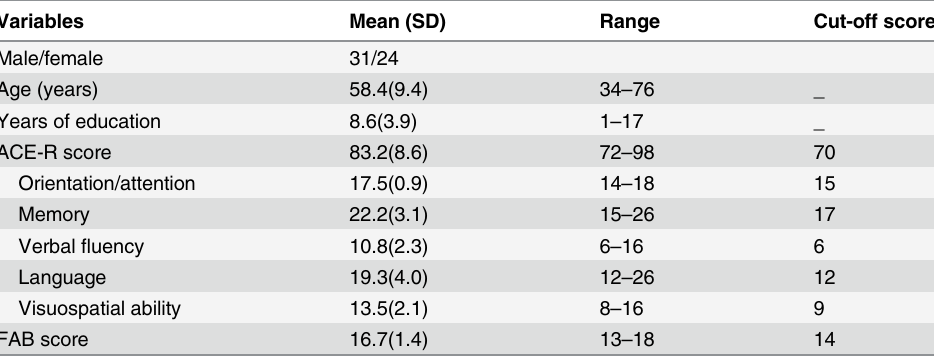
Table 1. Normative data of healthy controls on the ACE-R and FAB tests.